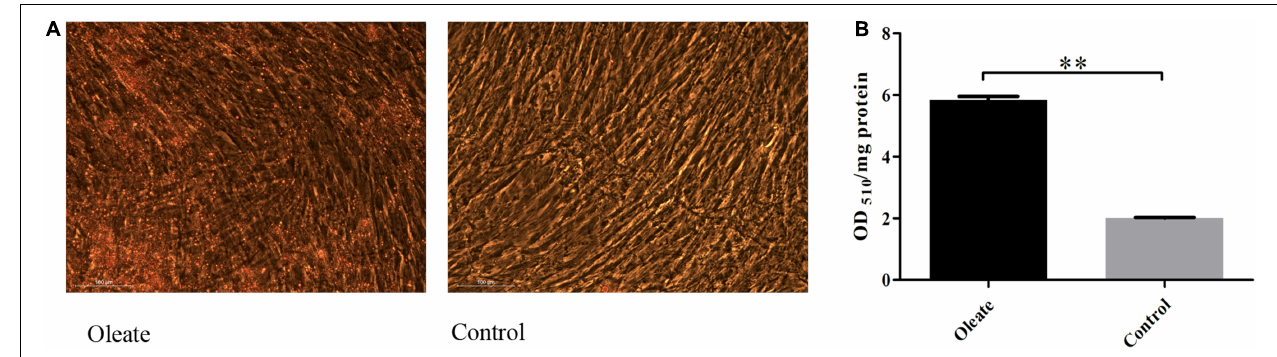
FIGURE 3 | Oil red O staining and content of oil red O at 96 h of induced differentiation. (A) Oil red O staining at 96 h of induced differentiation. (B) The content of oil red O at 96 h of induced differentiation. ∗∗ extremely significant ( P <